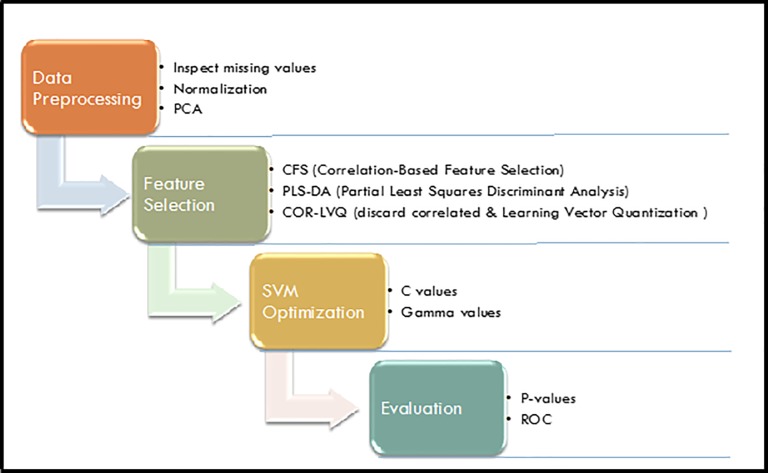
Study design from data preprocessing through performance evaluation.